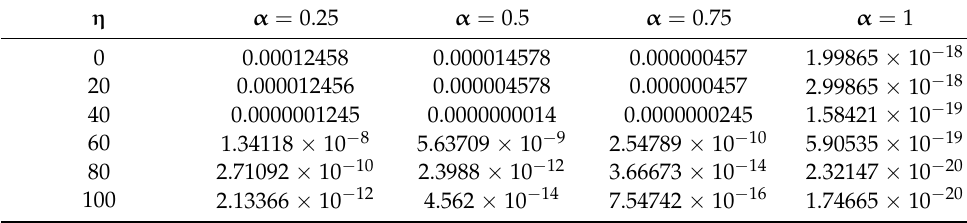
(cid:12) (cid:12) ( closed form solution ) − (cid:12)